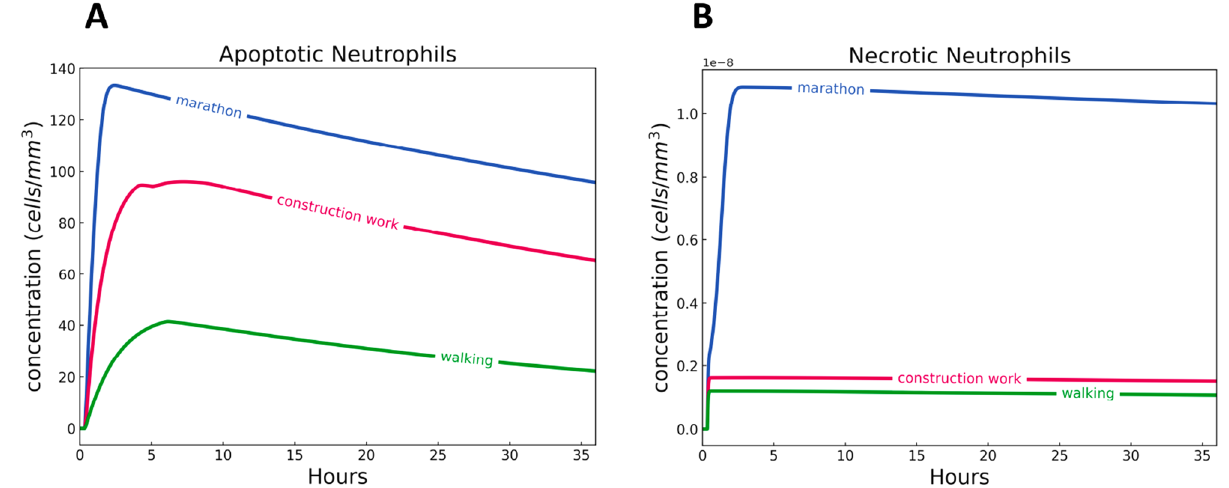
Figure 10. Dynamics of apoptotic and necrotic neutrophils during and after three physical activities. Marathon induces the most apoptotic neutrophils followed by construction work and walking. Marathon, which causes the highest level of ITMs, induces the most necrotic neutrophils as the innate immune system picks the necrotic death pathway to further aggravate the ongoing inflammation.